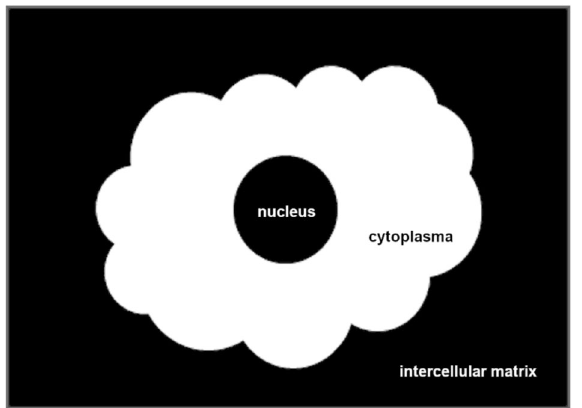
Figure 4. Cell model. The model for each cell contains a dark circular nucleus, a bright cell-cytoplasm of any shape, and a dark intercellular